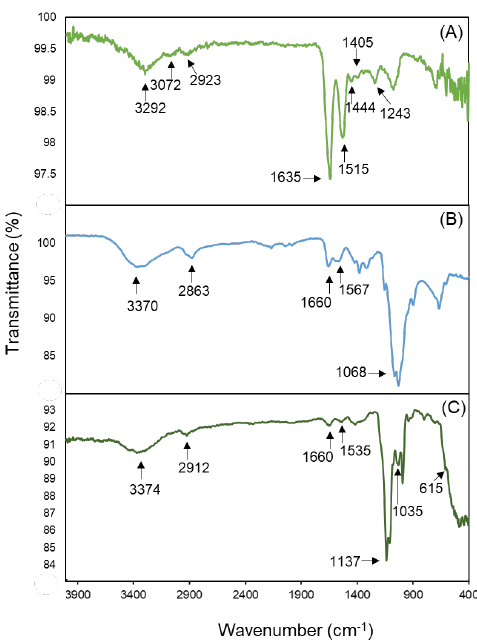
Figure 6. Fourier-transform infrared spectrums of ( A ) trypsin, ( B ) chitosan, and ( C ) trypsin-loaded chitosan particles made by SMART.